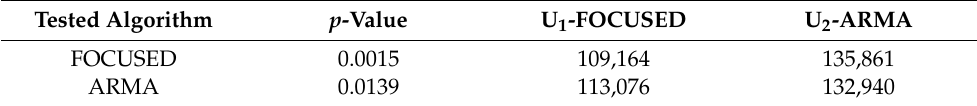
Table 3. Results of Mann-Whitney U test comparison of FOCUSED and ARMA models. Tested